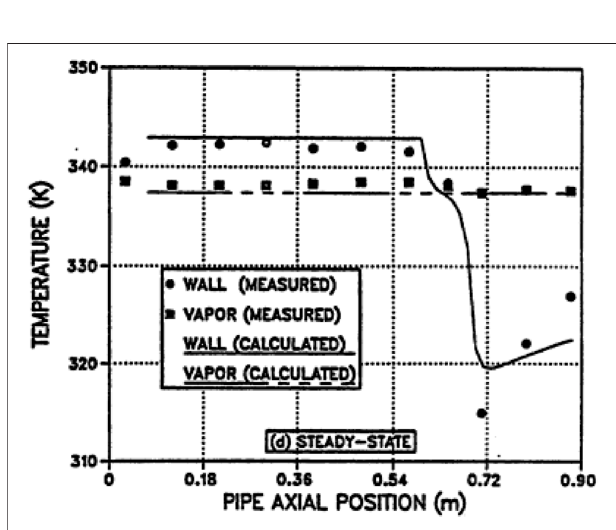
FIGURE 11 | Temperature distribution in the steady state (Tournier and El-Genk,